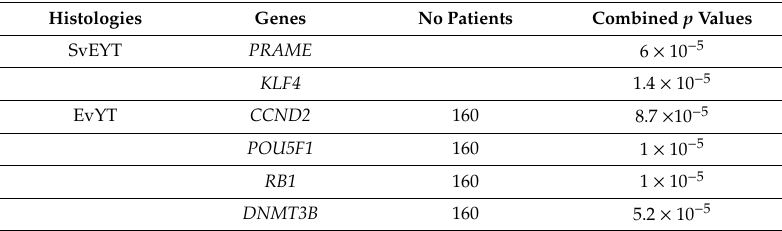
Table 1. RNA expressions of genes with overlaps among histologic types.